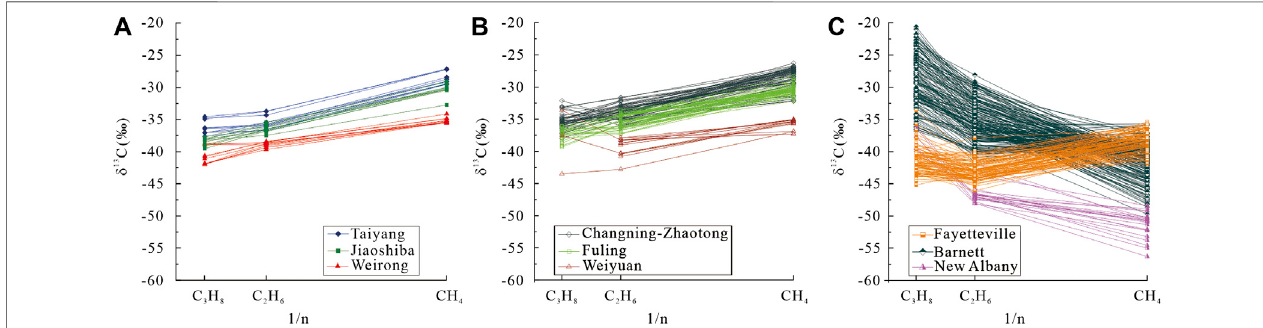
FIGURE3| Stablecarbonisotopiccompositionsversus1/nwherenisthecarbonnumberofmethane,ethane,andpropanefromTaiyang,Jiaoshiba,andWeirong gas fi eldsintheSichuanBasin (A) .Gasesfromthesethreegas fi eldsallhavecarbonisotopicreversalamongthemethane,ethane,andpropane( δ 13 C 1 > δ 13 C 2 > δ 13 C 3 ). AlsoshownarepublisheddataaboutshalegasesfromtheChangning-Zhaotong,Fuling,andWeiyuannationalshalegasdemonstrationzones (B) andshalegasesfrom the Barnett, New Albany, and Fayetteville shale (see text). (C) Modi fi ed from Chung et al.